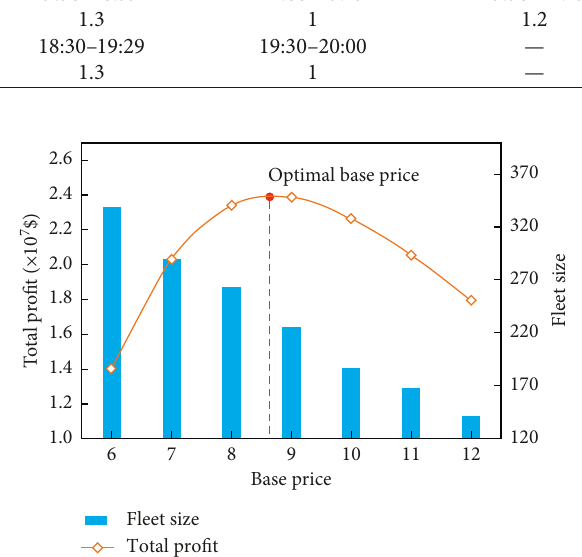
Figure 7: The effect of the base price on the system